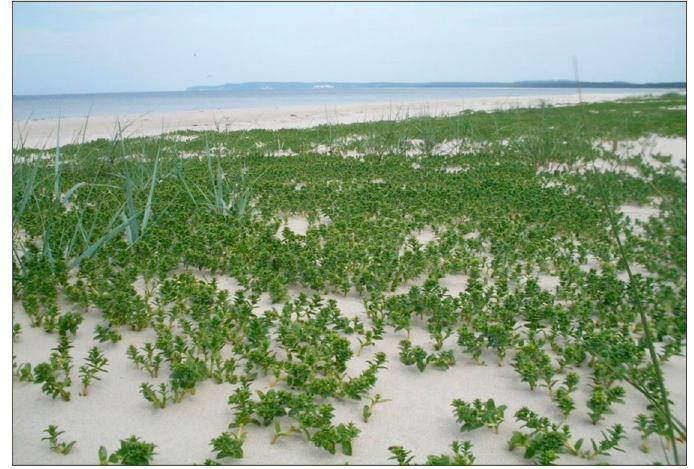
Figure 1. Honckenya peploides on the west coast of the Baltic Sea.